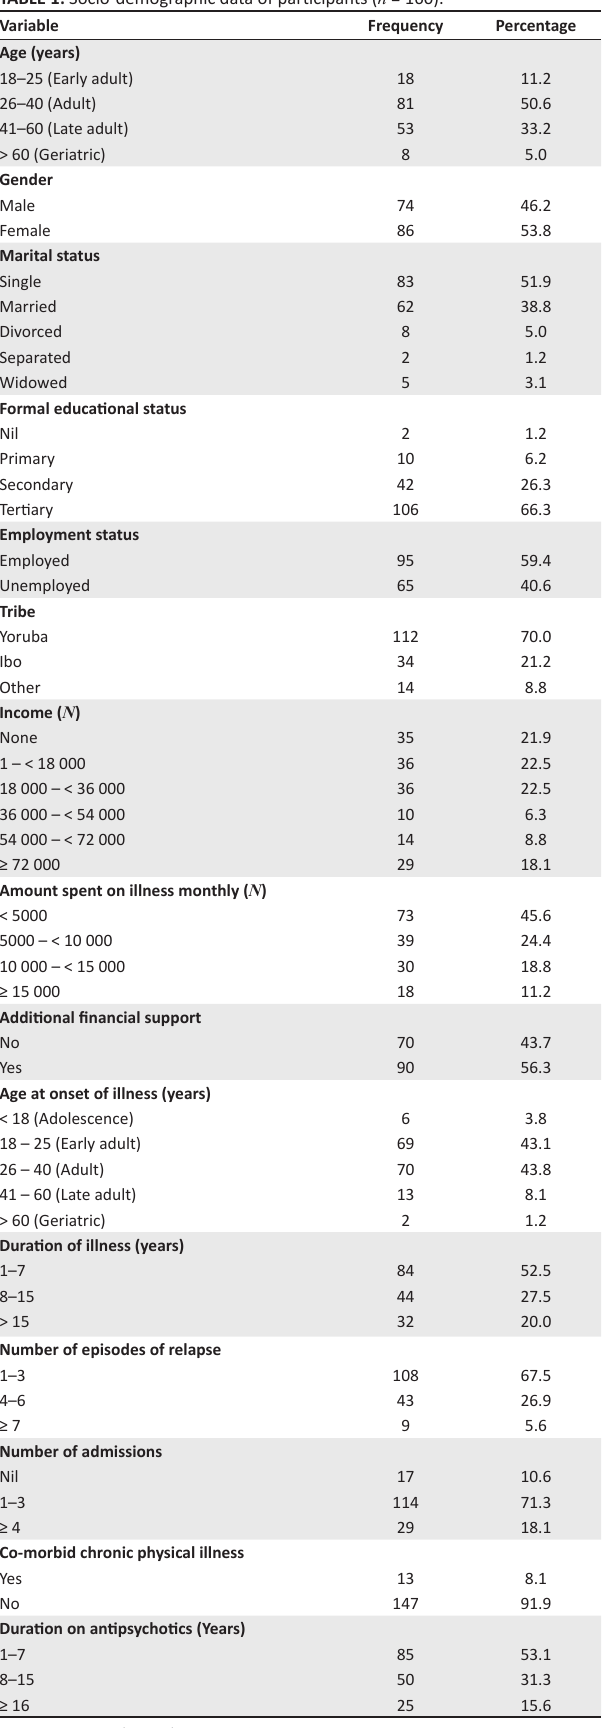
TABLE 1: Socio-demographic data of participants ( n = 160). TABLE 2: Frequency and severity of suicidality amongst the participants